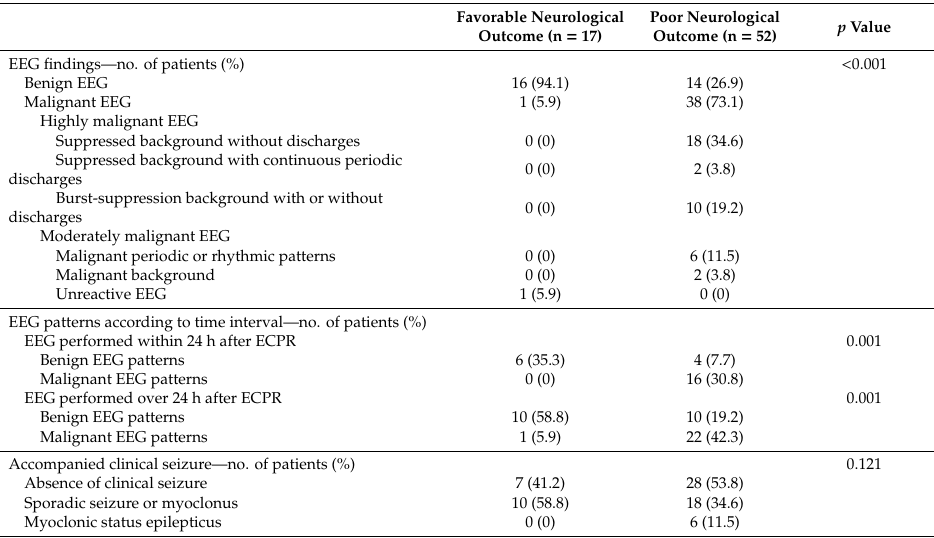
Table 3. Findings of